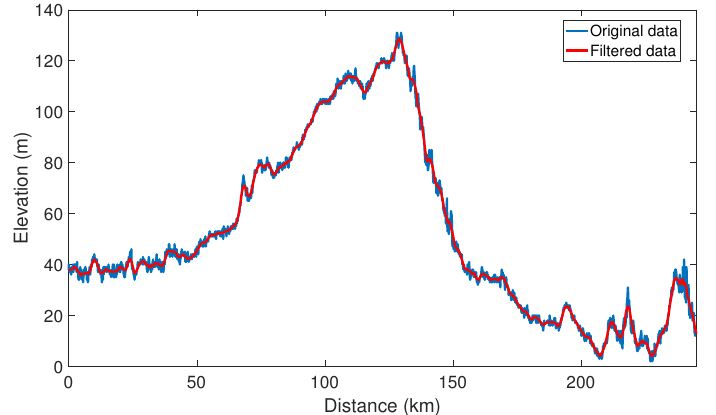
Figure 14. Original and filtered elevation profiles of the route Chiriguaná–Santa Marta. Now, the curvature radii vs. distance profile was calculated by using Algorithm 1, which produced the vector (cid:126) r C , g . The location and radii of the curves along the route are presented in Figure 15. This figure was obtained by plotting (cid:126) r C , g against (cid:126) D is , g . In this case, 32 curves were identified with r C , th = 800 m, where the minimum curvature radius was 255 m.